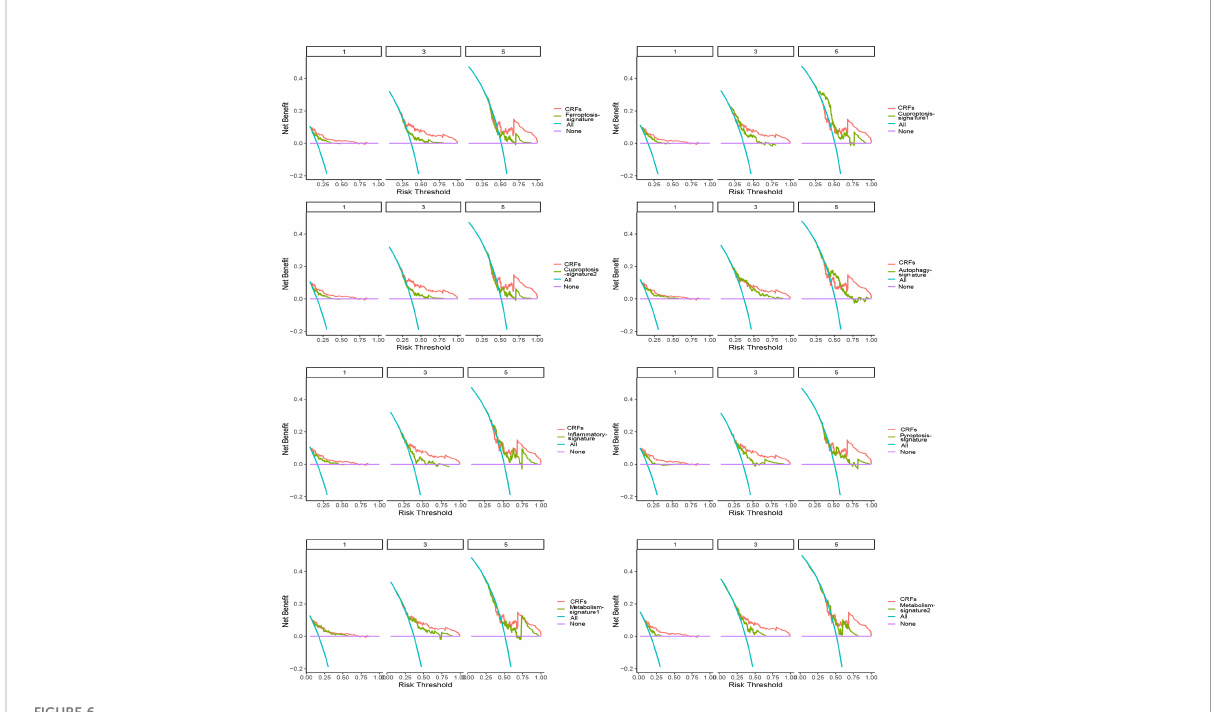
FIGURE 6 Comparison of CRFs with other gene